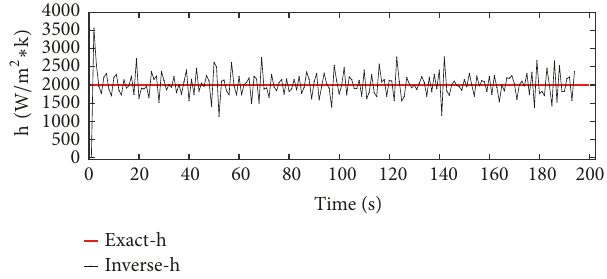
Figure 12: The heat transfer coefficient of the measuring point with 𝜎 = 0.01